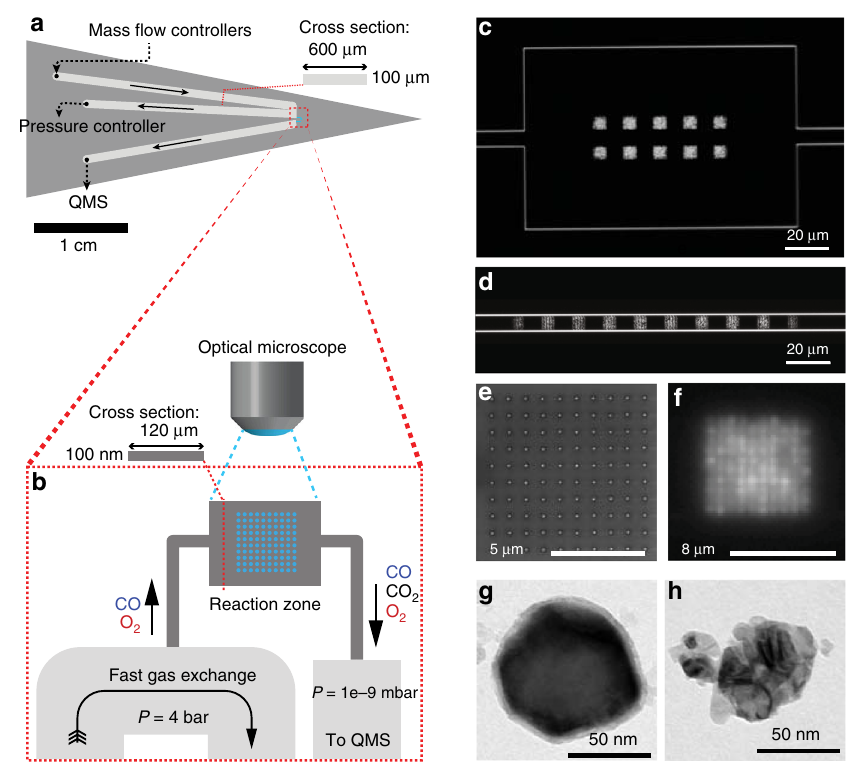
Fig. 1 Reactor chip layout and optical readout. a Schematic of the micro- and nanofabricated reactor chip comprising a micro fl uidic in- and outlet system that connects to the model catalyst bed, as well as the high-pressure gas handling system and the QMS, respectively. The cross-sectional dimensions of the micro fl uidic channels are also shown. Arrows indicate fl ow direction. b Schematic depiction of the model catalyst bed (reaction zone) of the chip that contains the catalyst nanoparticles and the corresponding cross-sectional dimensions of the well-mixed reactor in ( c ). Note that the schematics are not drawn to scale. The entire catalyst bed is imaged by dark- fi eld optical microscopy that resolves all particles individually based on their optical scattering signature. c Dark- fi eld scattering image of a well-mixed catalyst bed with dimensions 180 μ m × 120 μ m × 100 nm (L × W × H), containing ten Cu nanoparticle array patches, each comprising 100 individual particles with a diameter of 120 nm and a thickness of 40 nm. d Dark- fi eld scattering image of the plug- fl ow catalyst bed consisting of a straight channel with 10 μ m × 100 nm cross section and decorated with ten array patches, each comprising 100 individual particles with the same dimensions as in ( c ). e SEM image of a 100 Cu nanoparticle array patch. f Zoom in dark- fi eld image of a 100 Cu nanoparticle array patch. g TEM image of a representative single Cu nanoparticle reduced in 1.2% H 2 at 400°C. The slight surface oxide stems from exposure to air during transport to the TEM. h TEM image of a representative Cu nanoparticle oxidized in 0.2% O 2 at 400 °C, revealing the dramatic structural changes oxidation can